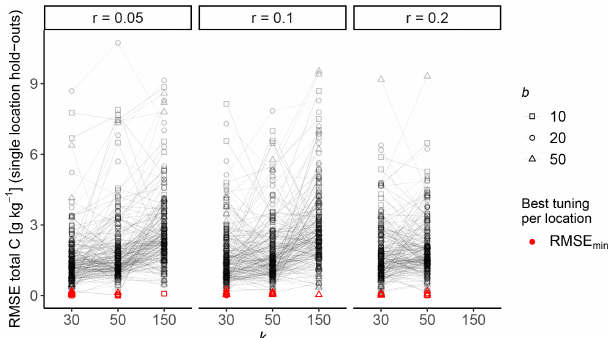
Figure A1. Performance profile of the 27 empirical parameter com- binations of RS-LOCAL tested on each of the 71 NABO sites. The root mean squared error (RMSE) of the plot-level transfer was as- sessed with the first two calibration samples for each time series of total carbon (C; see Fig. 1 for an illustration of the setup of the local predictive